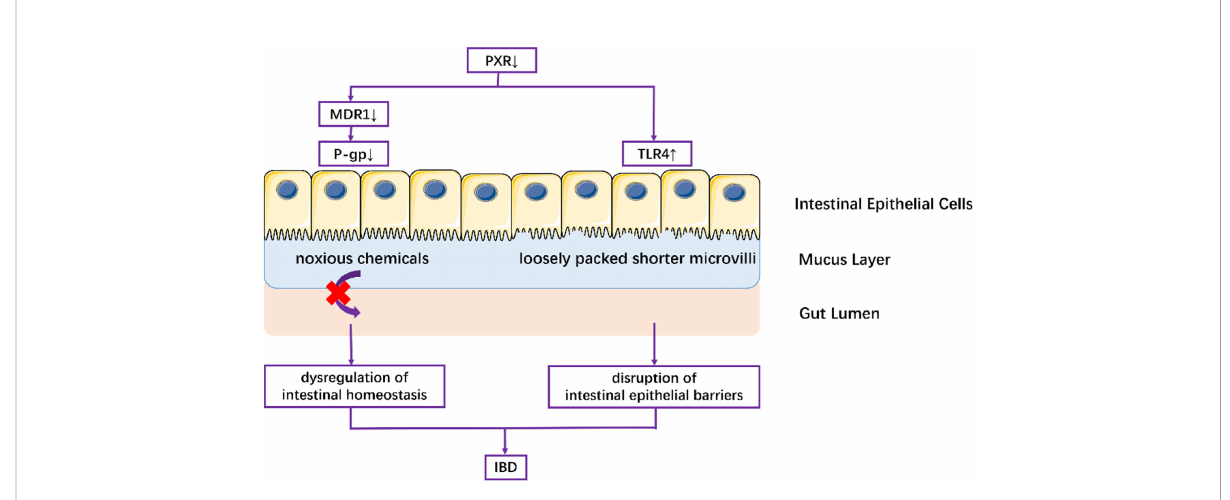
FIGURE 2 Mechanisms underlying the role of PXR in the pathogenesis of